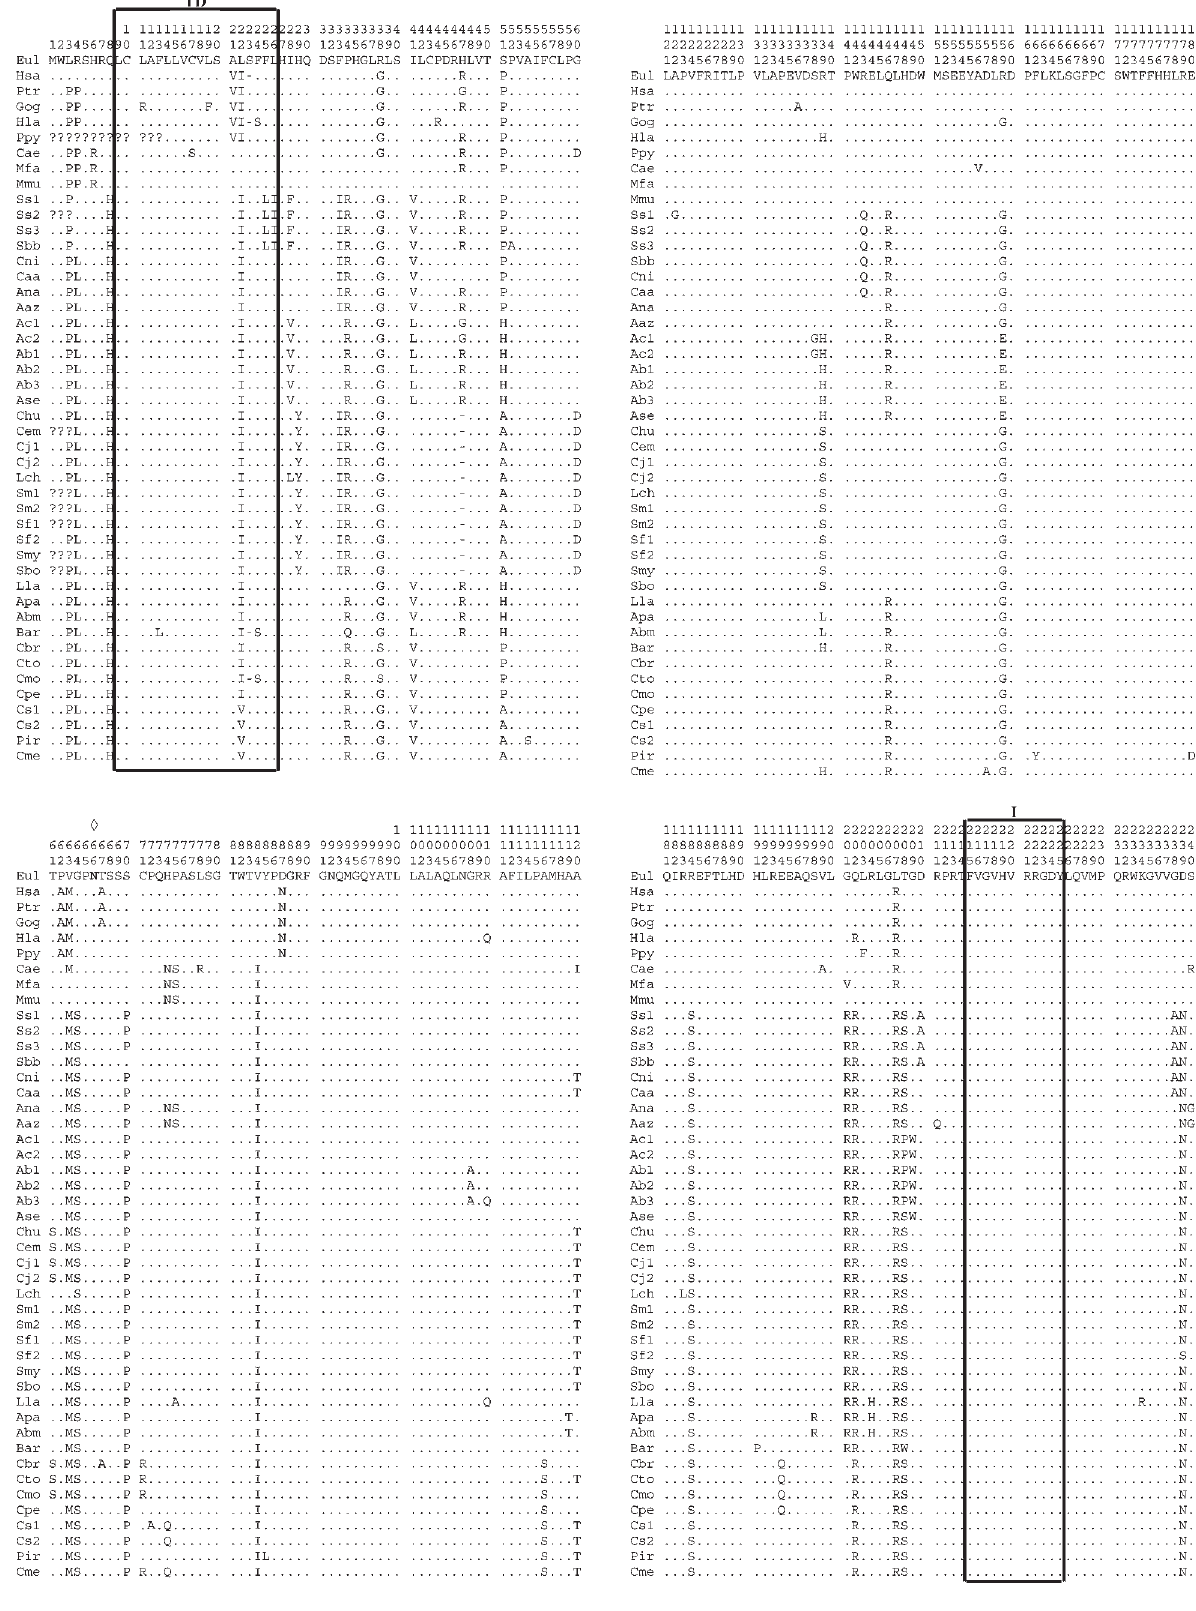
Figure 1 - Amino acid sequence of FUT1 gene. The lozenges ( ◊ ) indicate the glycosylation sites described by Larsen et al. (1990) and Apoil et al. (2000); the box indicates the position of the transmembrane domain (TD) and of the three conserved motifs described by Oriol et al .